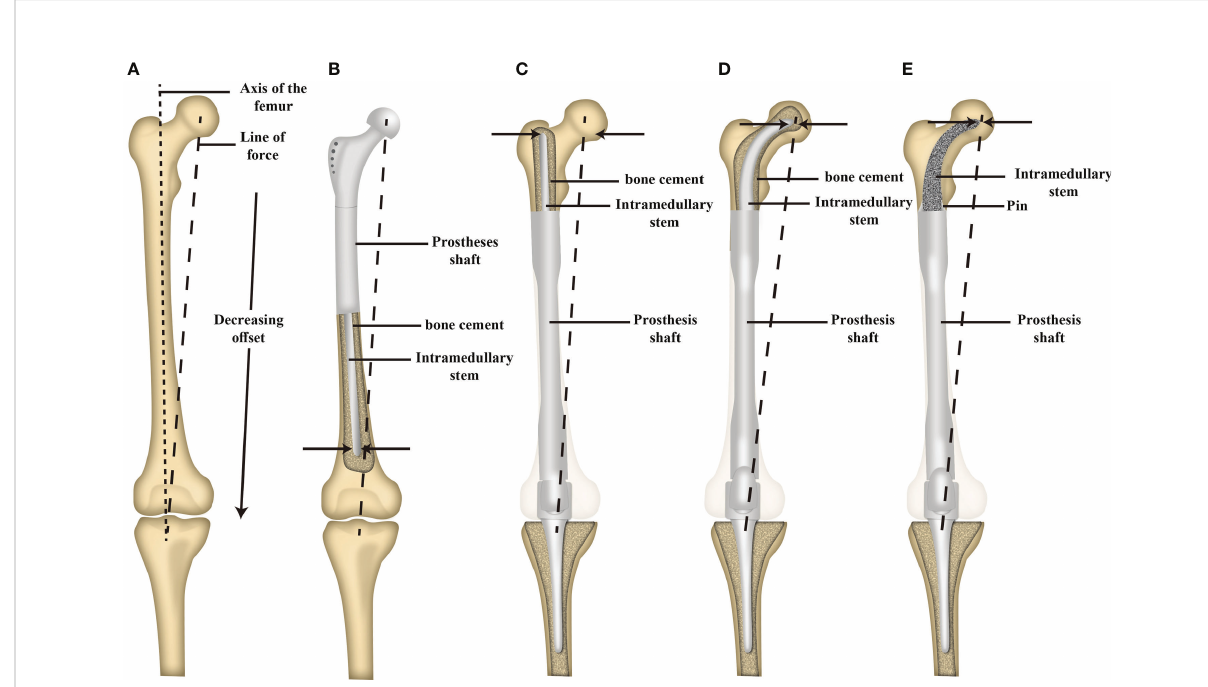
FIGURE 3 Schematic illustration of the offset distance between the line of force and the long axis of the femur and the offset distance of the tip of intramedullary stem between a proximal and distal femoral replacement. (A) The offset distance between the line of force and the long axis of the femur. (B) The offset distance of the tip of the intramedullary stem of proximal femoral replacement. (C) The offset distance of the tip of the intramedullary straight stem of distal femoral replacement. (D) The offset distance of the tip of the cemented INCS of distal femoral replacement. (E) The offset distance of the tip of the cementless INCS of distal femoral replacement. (INCS: intra-neck curved stem; Adapted from ref. (28) with